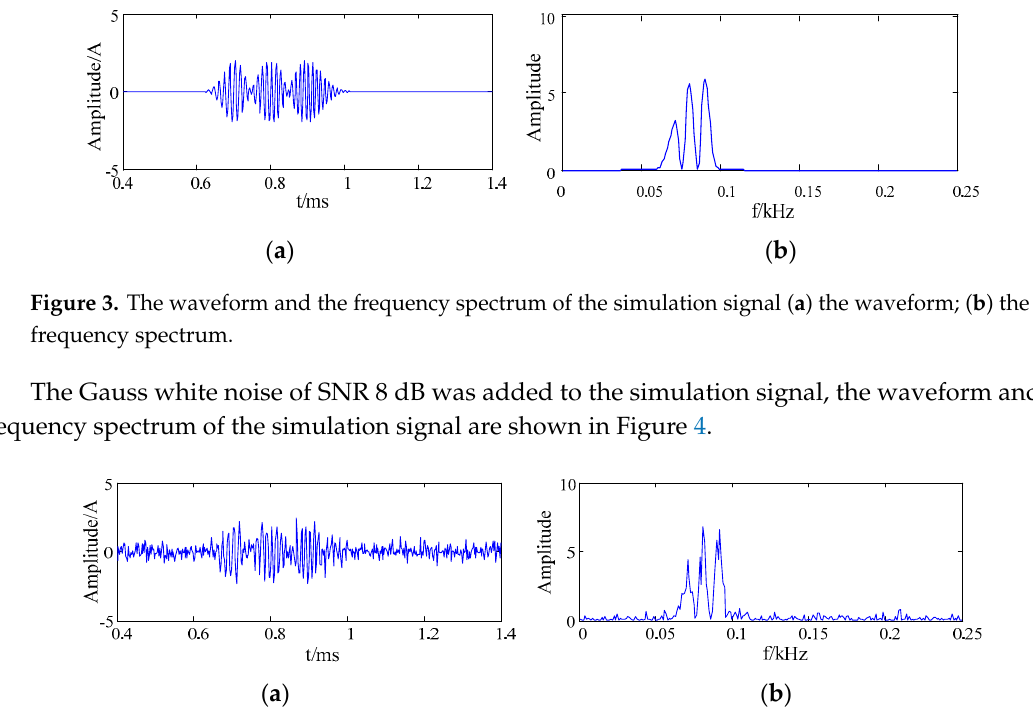
Figure 4. The waveform and the frequency spectrum of the simulation signal with noise ( a ) the waveform; ( b ) the frequency spectrum